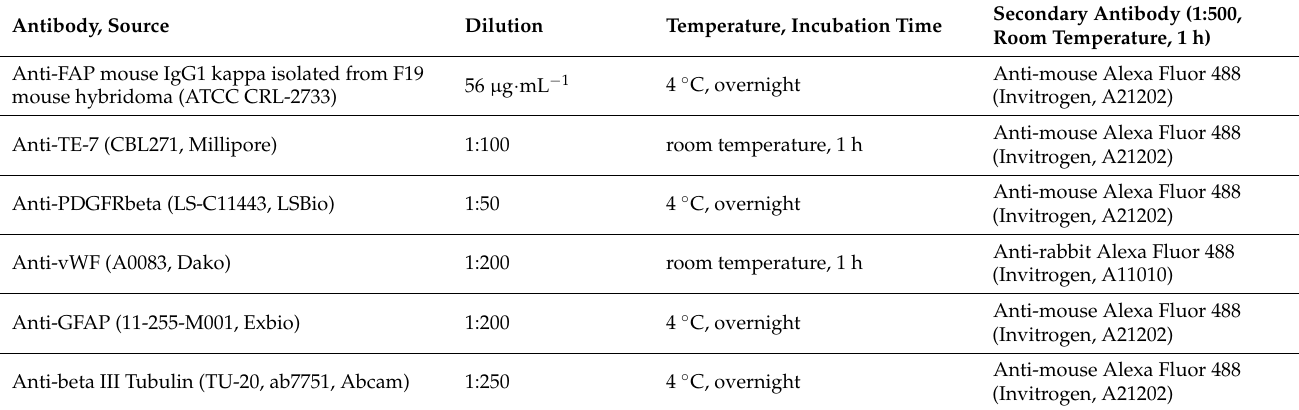
Table 2. Antibodies used for the characterization of cell cultures derived from human